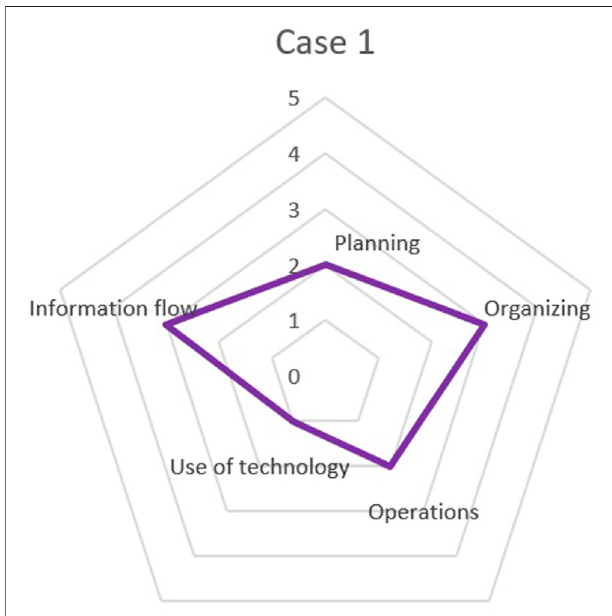
FIGURE 3 | Case 1 ’ s logistics maturity